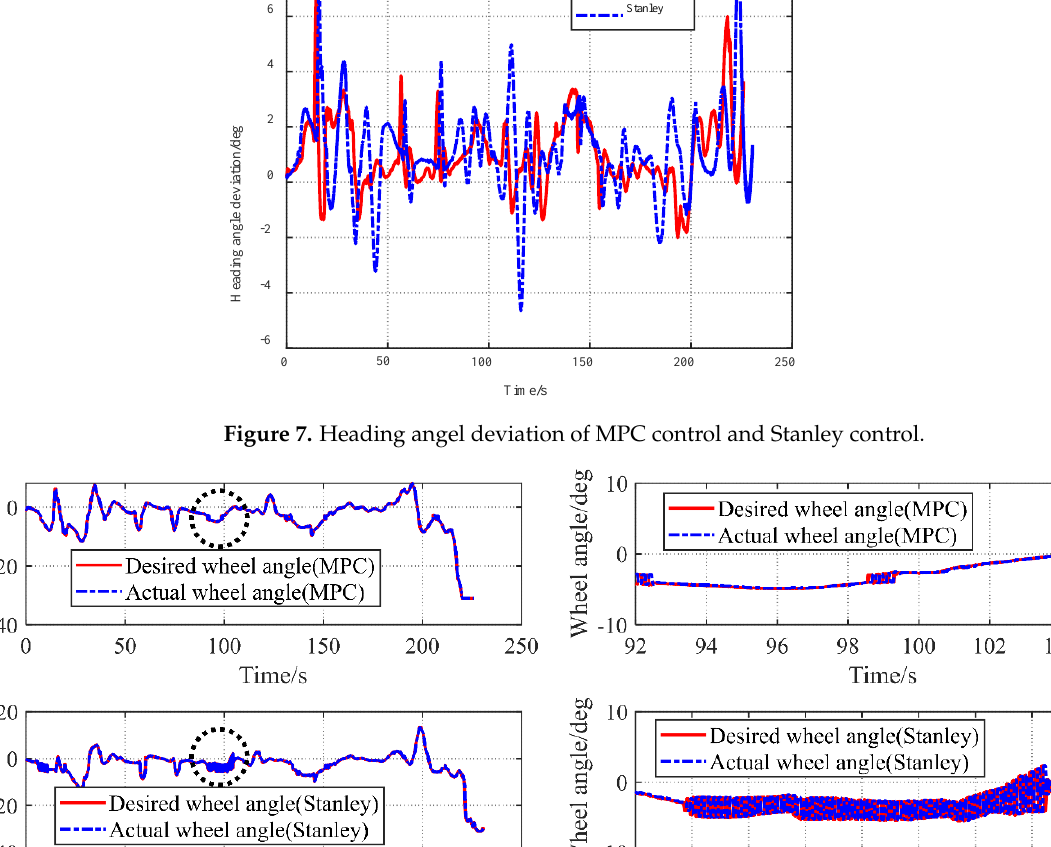
Figure 6. Global trajectory of MPC control and Stanley control ( left ). Large curvature route ( right ).